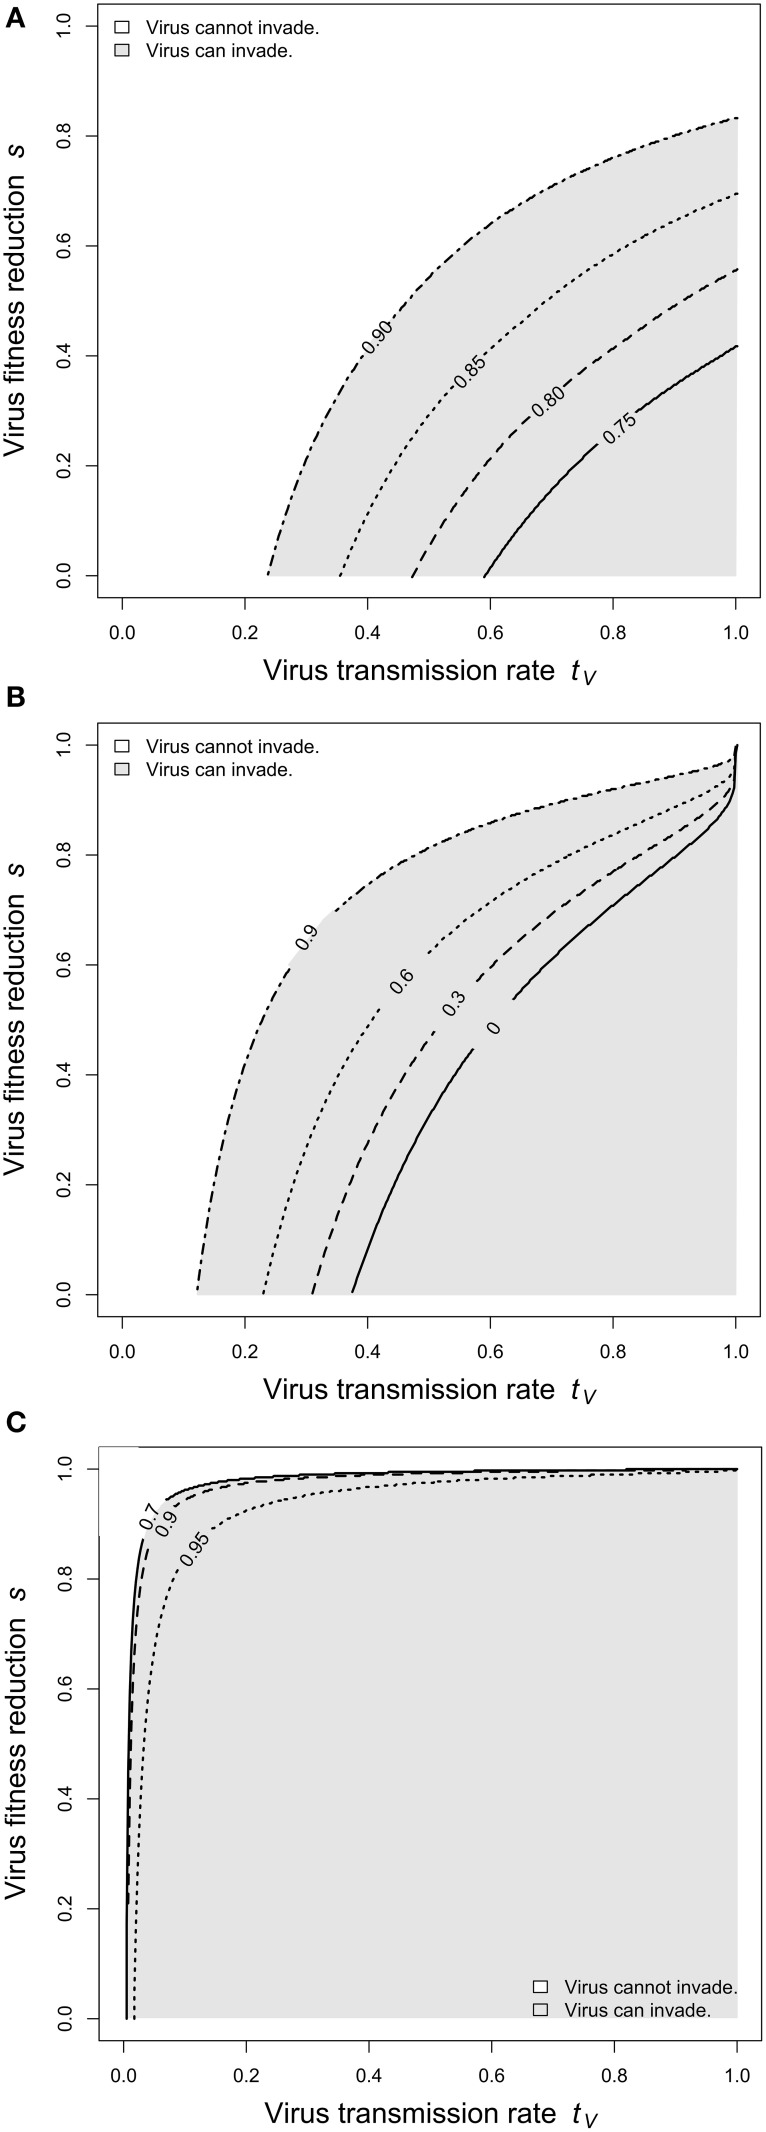
Virus invasibility for varying levels of larval competition. The parameter space spanned by virus transmission (tV) and cost of infection (s) was screened for parameter regions, in which the virus can invade the host population. (A) Adult competition model. Lines indicates dL = 0.7 (solid), dL = 0.8 (dashed), dL = 0.85 (dotted), and dL = 0.9 (dashed-dotted). (B) Larval competition model overcompensation. Lines indicates dL = 0 (solid), dL = 0.3 (dashed), dL = 0.6 (dotted), and dL = 0.9 (dashed-dotted). (C) Larval competition model undercompensation. Lines indicates dL = 0.7 (solid), dL = 0.9 (dashed), and dL = 0.95 (dotted). The figure shows that high levels of larval competition facilitate virus invasibility for the ACM and the LCM with overcompensation, but impede invasibility for the LCM and undercompensation. Further parameters are as in Figure 2.